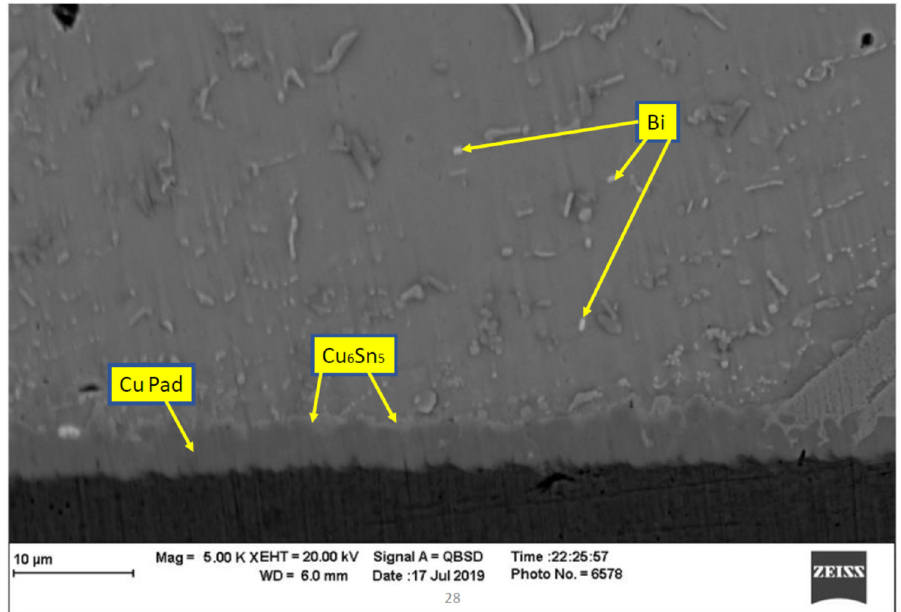
Figure 5. The microstructure of Cyclomax is not subject to thermal aging.